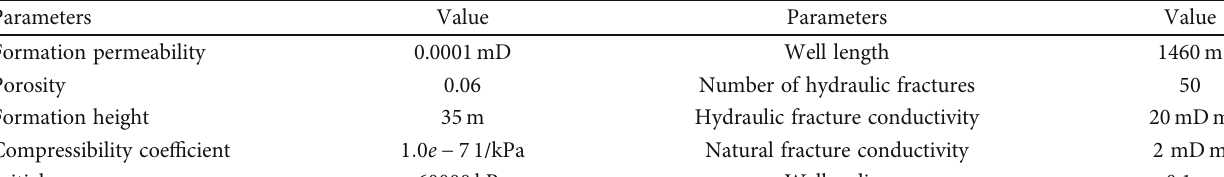
Table 1: Basic parameters of formation, horizontal wells, and fractures.